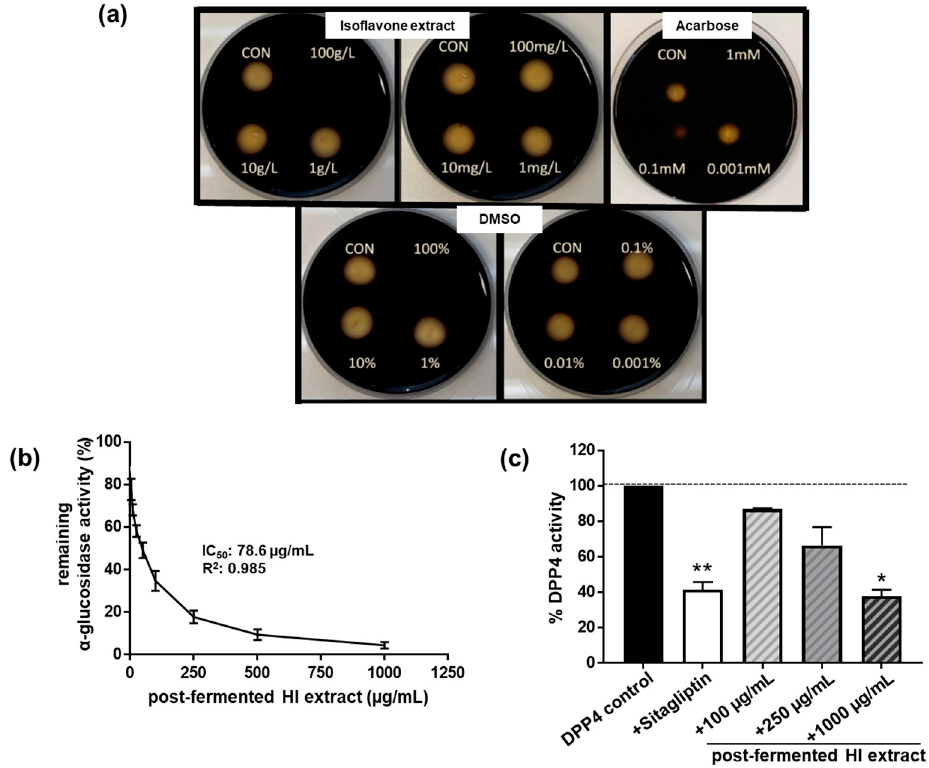
Figure 3. The post-fermented HI-rich extract did not affect ( a ) in vitro α -amylase activity, but inhibited ( b ) α -glucosidase activity as well as ( c ) dipeptidyl peptidase-4 (DPP4) enzyme activity in a dose-dependent manner. For measuring in vitro α -amylase inhibition, the disc diffusion assay was applied. Porcine pancreatic α -amylase was mixed with increasing concentrations of HI extract (final concentrations as indicated) and administered onto the filter discs filled with medium comprising 1% agar–agar and 1% starch. After overnight incubation at 37 °C, starch/agar plates were iodide- stained. α -Amylase inhibition in samples was determined by matching the diameter of the cleared zones. HI extract-, DMSO- (solvent control for the HI extract) and acarbose- (positive control) treated filter discs were compared to control filter discs (CON, α -amylase alone). The assay was conducted on two independent testing days. Exemplary results are shown. α -Glucosidase activity was deter- mined spectrophotometrically. IC 50 was calculated using GraphPad Prism. DPP4 assay was per- formed in the presence of the following substances: DPP4 control: assay buffer; sitagliptin: 18 nM; post-fermented HI-rich extract as indicated. Values of remaining DPP4 enzyme activity (in %) com- pared to the DPP4 control are displayed. Results are mean values of n = 2–4 independent experi- ments. Error bars indicate standard deviation. ** p < 0.01; * p < 0.05, Kruskal–Wallis test ( p < 0.001), followed by Dunn’s multiple comparison test, compared to DPP4 control enzyme activity. 3.2. Pre- and Post-Fermented Soy Isoflavone Extracts Were Moderate Inhibitors of SGLT1- Mediated Glucose Transport To examine whether soy isoflavone extracts before (pre-) fermentation and HI-en- riched after (post-) fermentation affect SGLT1-mediated glucose transport, we employed Ussing chamber experiments using the Caco-2/PD7 cell monolayer model. Representative runs are given in Figure 4a, c. Adding either pre- or post-fermented extract at a concen- tration of 1 mg/mL to the Ussing chamber system substantially lowered the glucose-in- duced short-circuit current from 6.90 ± 0.36 to 4.05 ± 0.66 μ A/cm 2 (pre-fermented extract) and from 7.45 ± 0.69 to 4.51 ± 0.63 μ A/cm 2 (post-fermented HI-rich extract), respectively (Figure 4d). This represents a SGLT1 inhibition of approximately 60% for both extracts. In